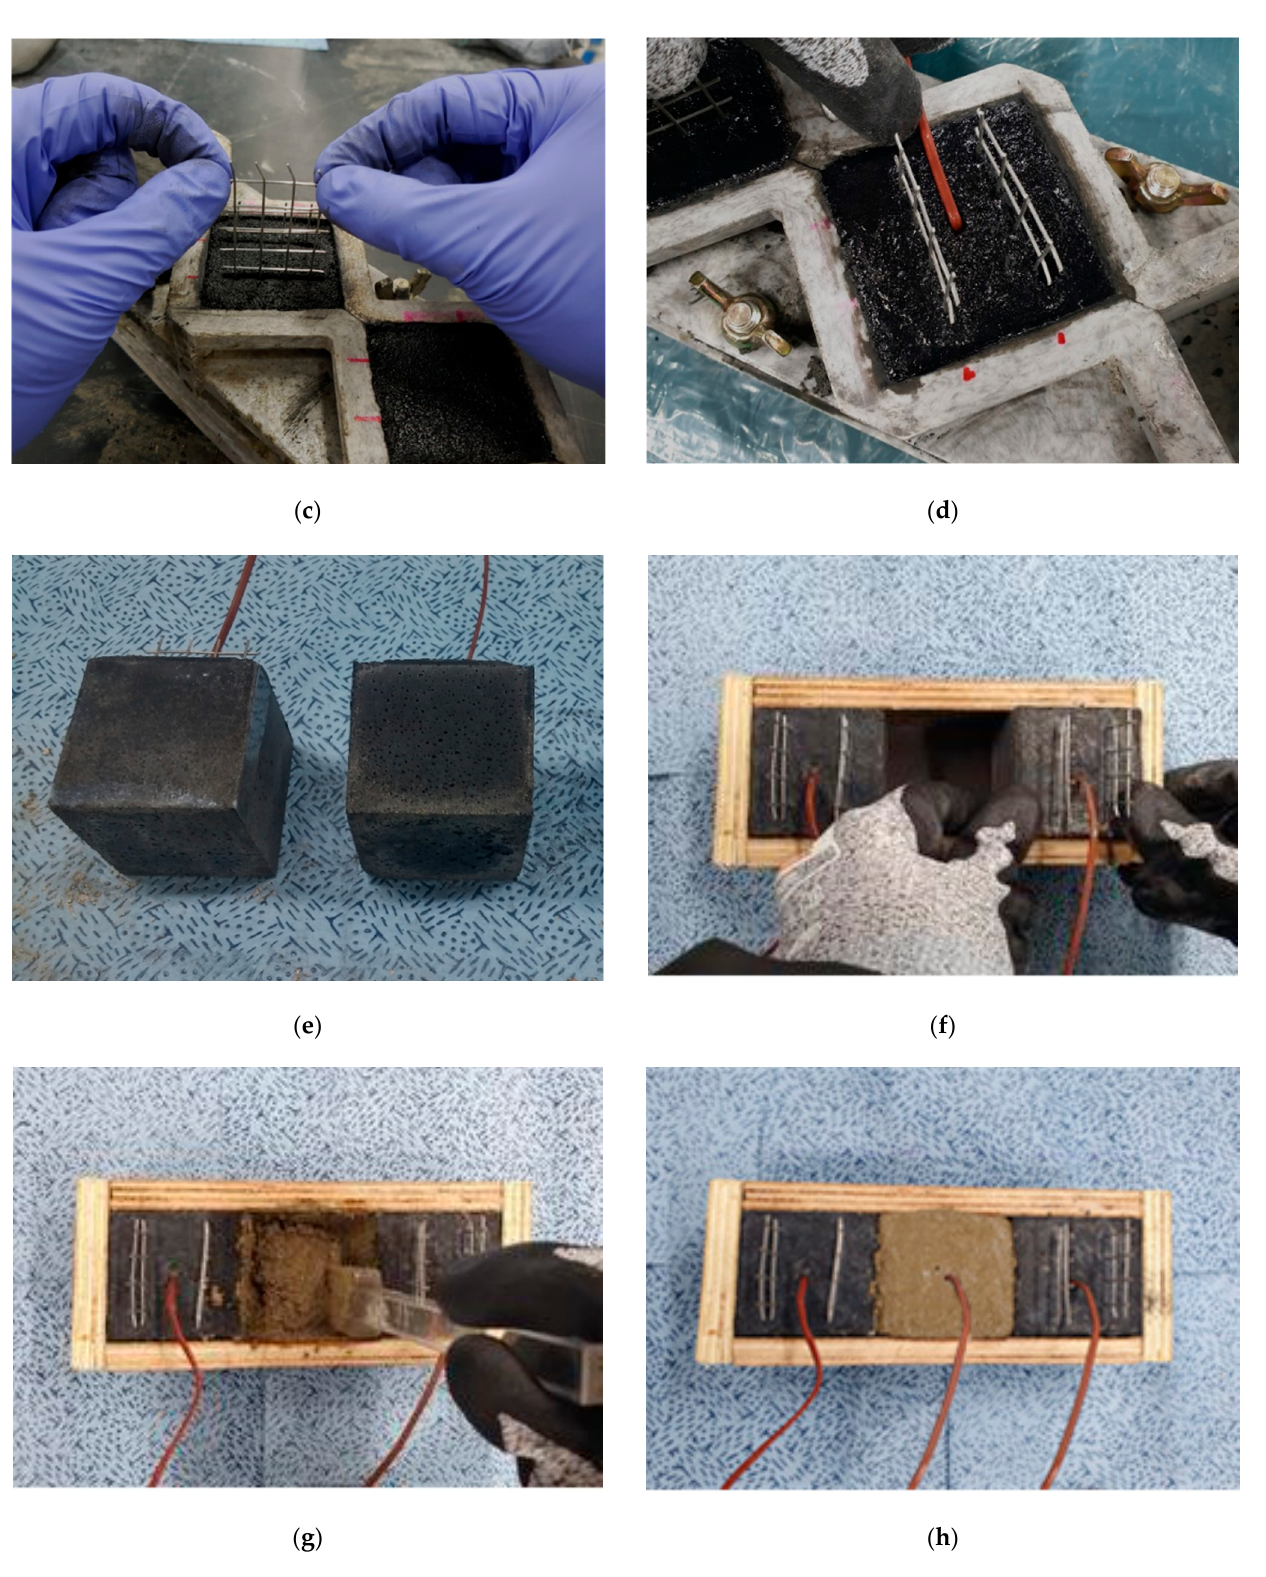
Figure 3. Fabrication process of the test specimens. ( a ) Measuring. ( b ) Mixing (3 min). ( c ) Installing a stainless-steel mesh. ( d ) Installing a thermocouple in the heating part. ( e ) Curing of the heating part (91 d). ( f ) Installing the heating part. ( g ) Tamping of the curing part. ( h ) Installing a thermocouple in the curing part. The heat curing experiment was performed by adjusting the ambient temperature in the chamber. The properties of the chambers used are listed in Table 2. To simulate the